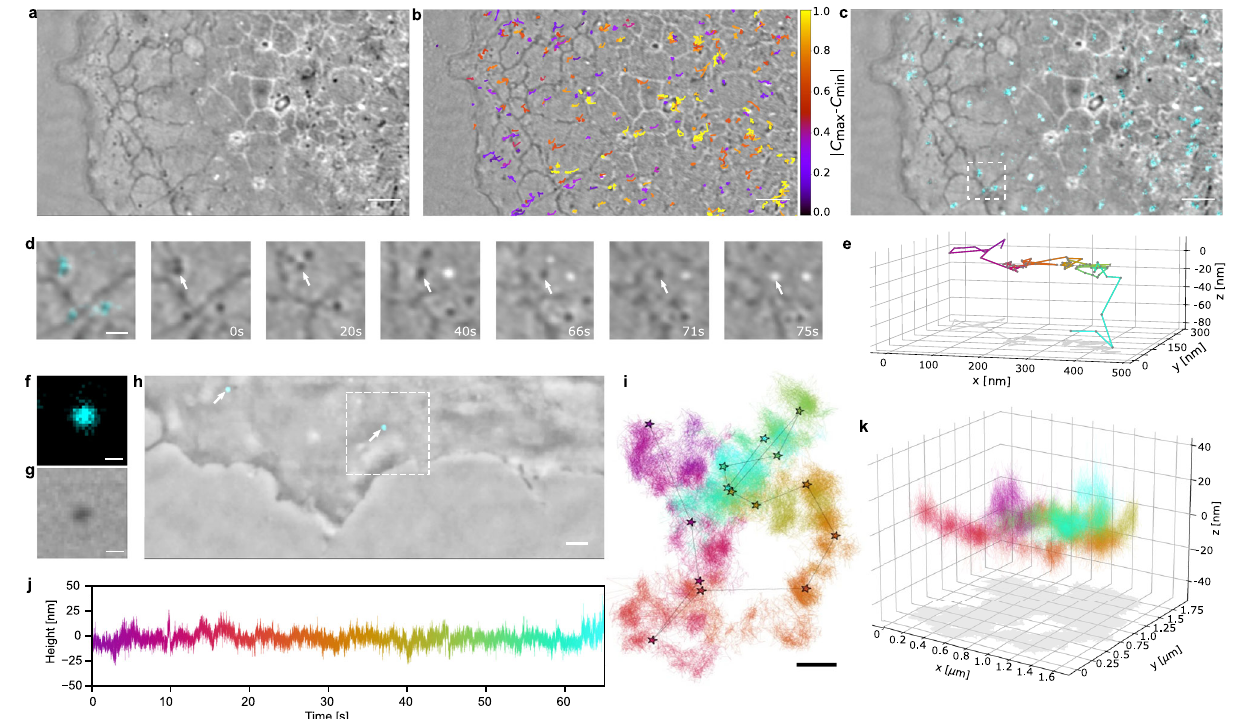
Fig. 5 | 3D tracking of clathrin-coated pits and SARS-CoV-2 on the plasma membraneofalivecell.a ExemplaryrawC-iSCATimageoftheperipheryofaCOS- 7 cell showing vesicles, ER network and MTs. Scale bar is 2 μ m in a – c . b Overlay of singleparticletrajectoriesofvesiclesdetectedandtrackedin a .Colormapencodes theabsolutevalueofthecontrastchangenormalizedforeachtrajectory. c Overlay of a with CF of clathrin labeled with mCerulean3 (cyan). d Close-up of c including clathrin-coated pits. Time course over 75 s shows contrast inversion of a clathrin- coated pit indicated with a white arrow. Scale bar is 500nm. e Extracted 3D tra- jectory of the clathrin-coated pit marked in d . Color map encodes the temporal evolution starting from t =0s (magenta) to t =75s (cyan). CF ( f ) and C-iSCAT ( g )